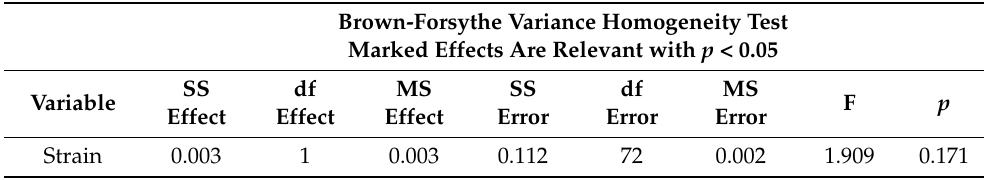
Table 2. Verification of the assumption of the homogeneity of variance by means of the Brown- Forsythe test with sterilization adopted as the grouping variable.